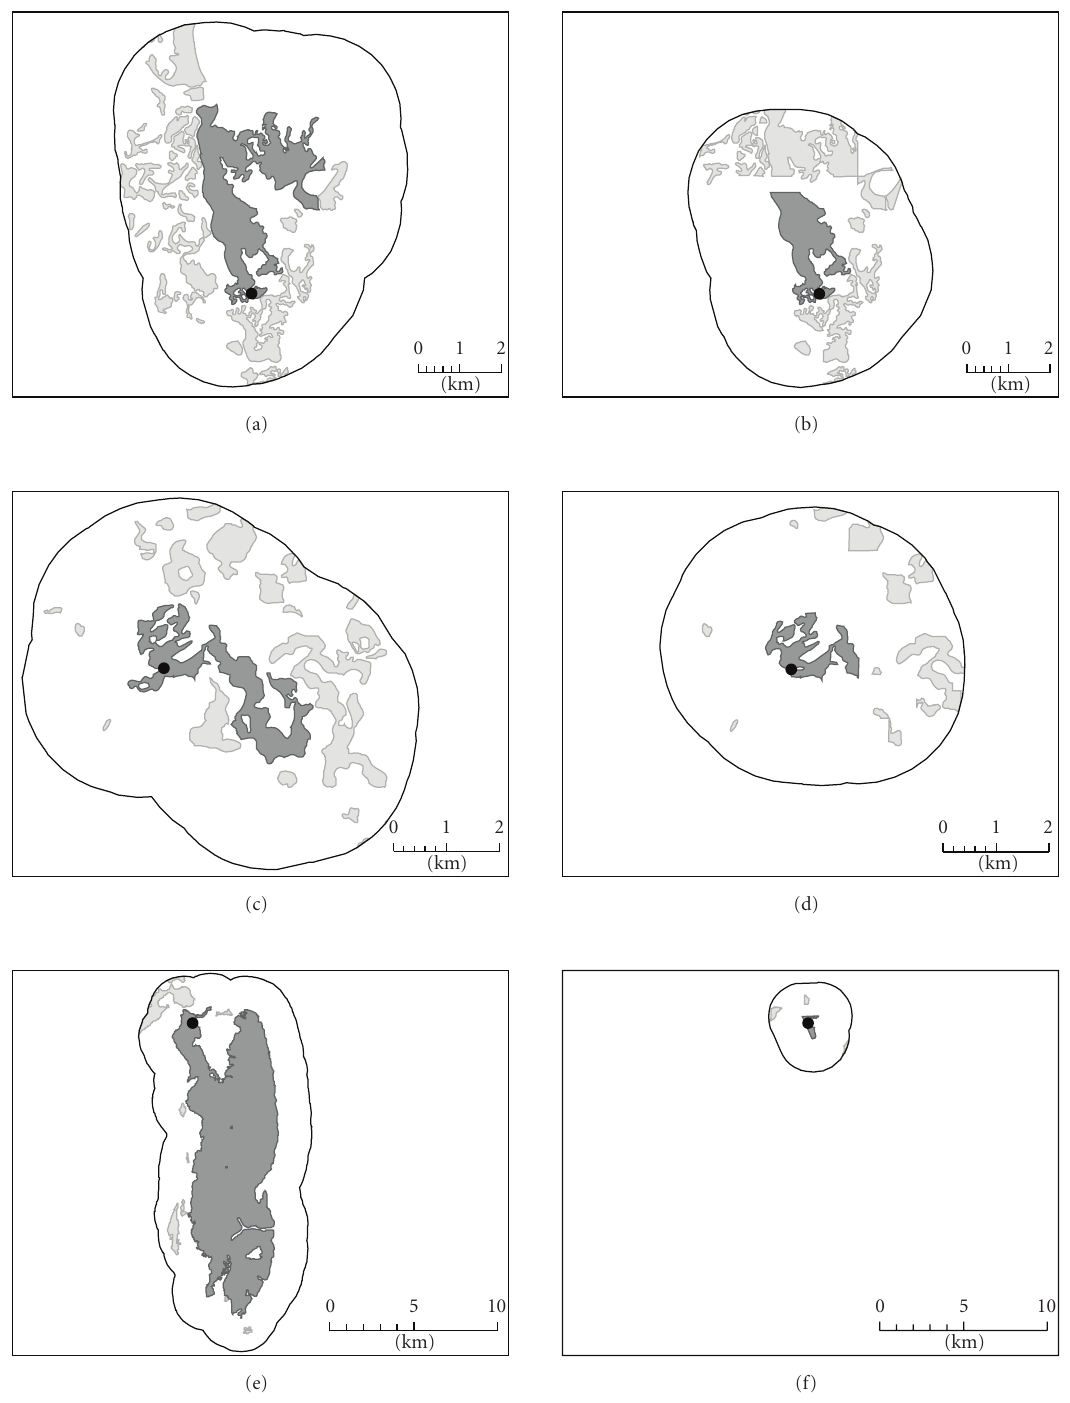
Figure 2: Landscape structure around three representative populations sampled for genetic variation. In each case, the location of the genetic sample is shown by the filled circle, the dark polygon represents the home polygon of the sample (with the home polygon being the soil polygon from which the genetic collection was made merged with all adjoining suitable soil polygons), and the light shading represents suitable soil polygons within the 2 km bu ff er (shown as a dark line). (a, b) presettlement and extant landscapes, respectively, for Liatris ohlingerae at Archbold Biological Station West. The population is protected and nearby habitat loss and fragmentation is moderate. (c, d) presettlement and extant landscapes, respectively, for Hypericum cumulicola at Lizzie Lake. The population is unprotected and nearby habitat loss and fragmentation is high. (e, f) presettlement and extant landscapes, respectively, for Dicerandra frutescens at Camp Florida. The population is unprotected and nearby habitat loss and fragmentation is